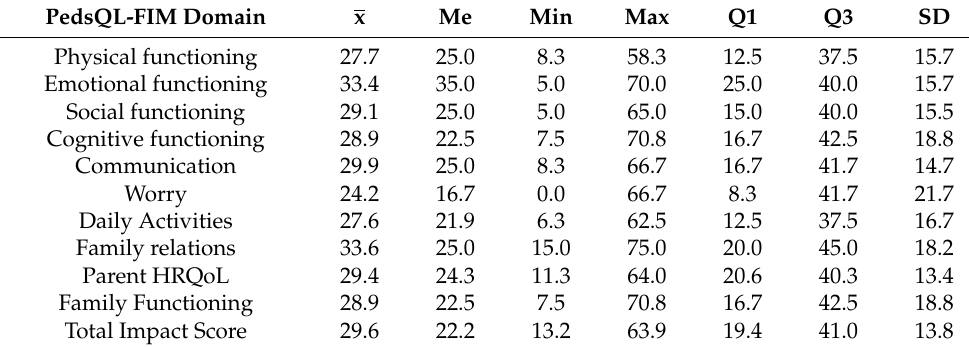
Table 3. Results of PedsQL Family Impact